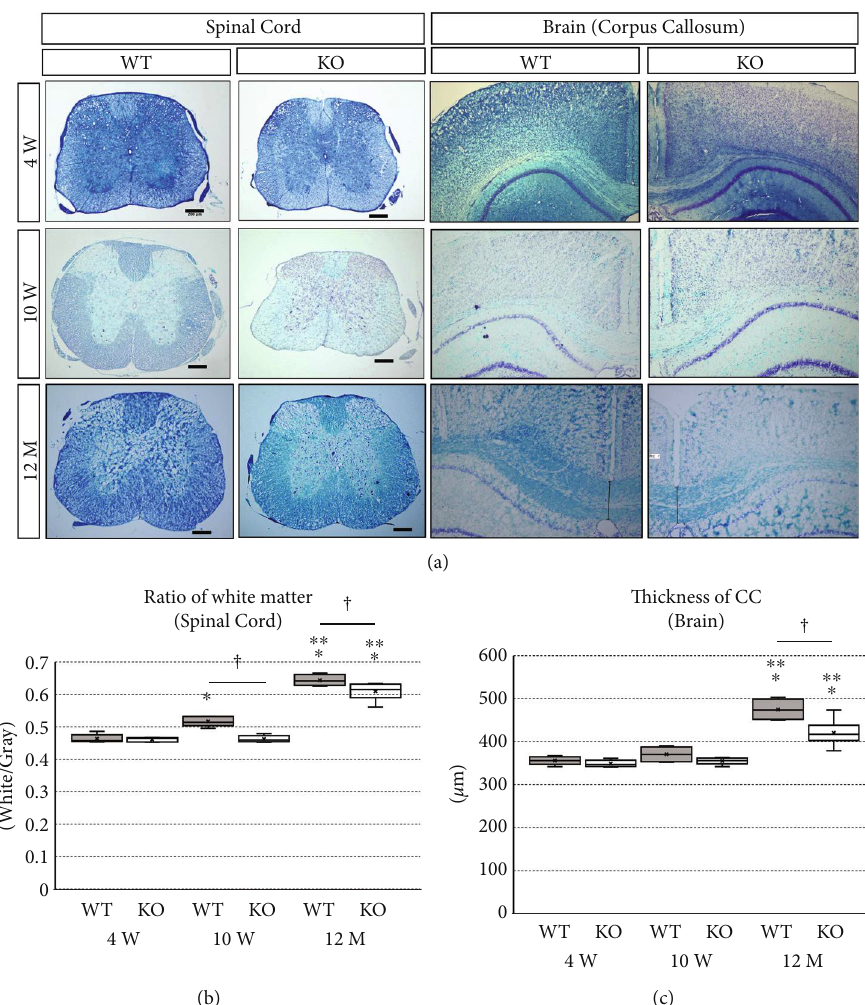
Figure 4: Luxol Fast Blue staining of the brain and spinal cord sections. Wild-type (WT) and miR-23-27-24 cluster knockout (KO), n = 5 per group. (a) Representative images of Luxol Fast Blue stained transverse sections of the thoracic spinal cord and coronal sections of the corpus callosum in WT and KO mice at 4 weeks, 10 weeks, and 12 months of age. Scale bars: 200 μ m. (b) The ratio of the white matter area to the total area of the spinal cord (ratio of white matter). ∗ Compared to 4-week-old. ∗∗ Compared to 10-week-old. † Comparison between WT and KO mice, p < 0 : 05 . (c) The thickness of the corpus callosum (CC). ∗ Compared to 4-week-old. ∗∗ Compared to 10-week- old. † Comparison between WT and KO mice, p < 0 : 05